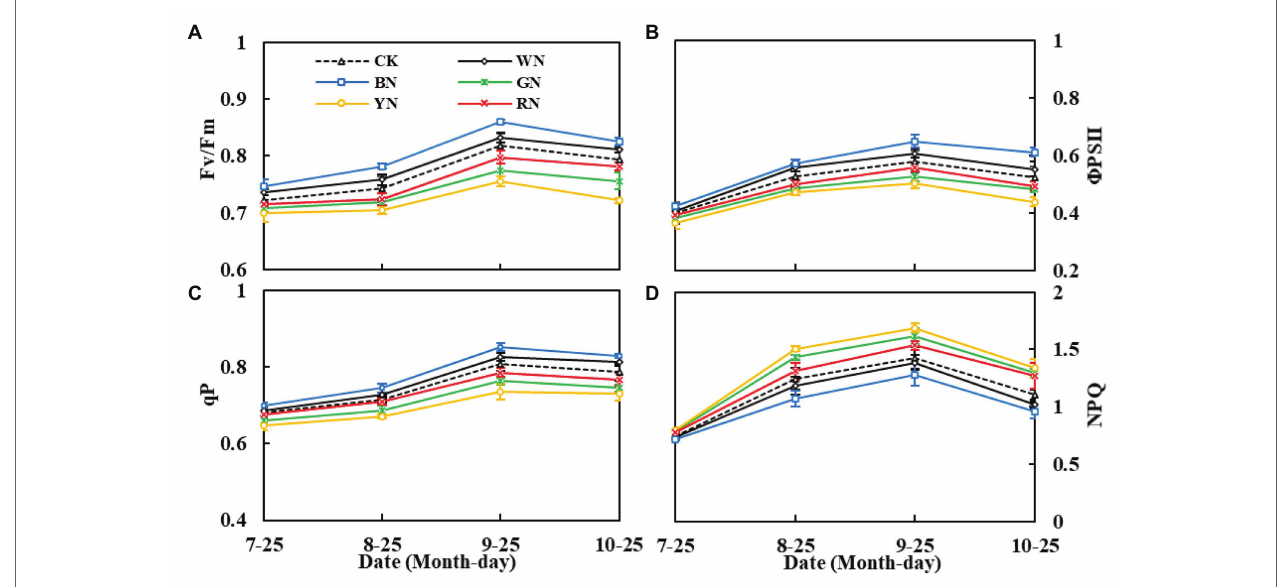
FIGURE 6 | The effect of photo-selective nets on the fluorescence parameters of green onion leaves at different growth stages. (A) Maximum photochemical efficiency of PSII under dark adaptation (Fv/Fm), (B) actual photochemical efficiency ( Φ PSII), (C) photochemical quenching coefficient (qP), (D) non-photochemical quenching coefficient (NPQ). CK, control; WN, white photo-selective nets; BN, blue; GN, green; YN, yellow; and RN, red. Values are average ± SD, n = 18. Error bars indicate standard